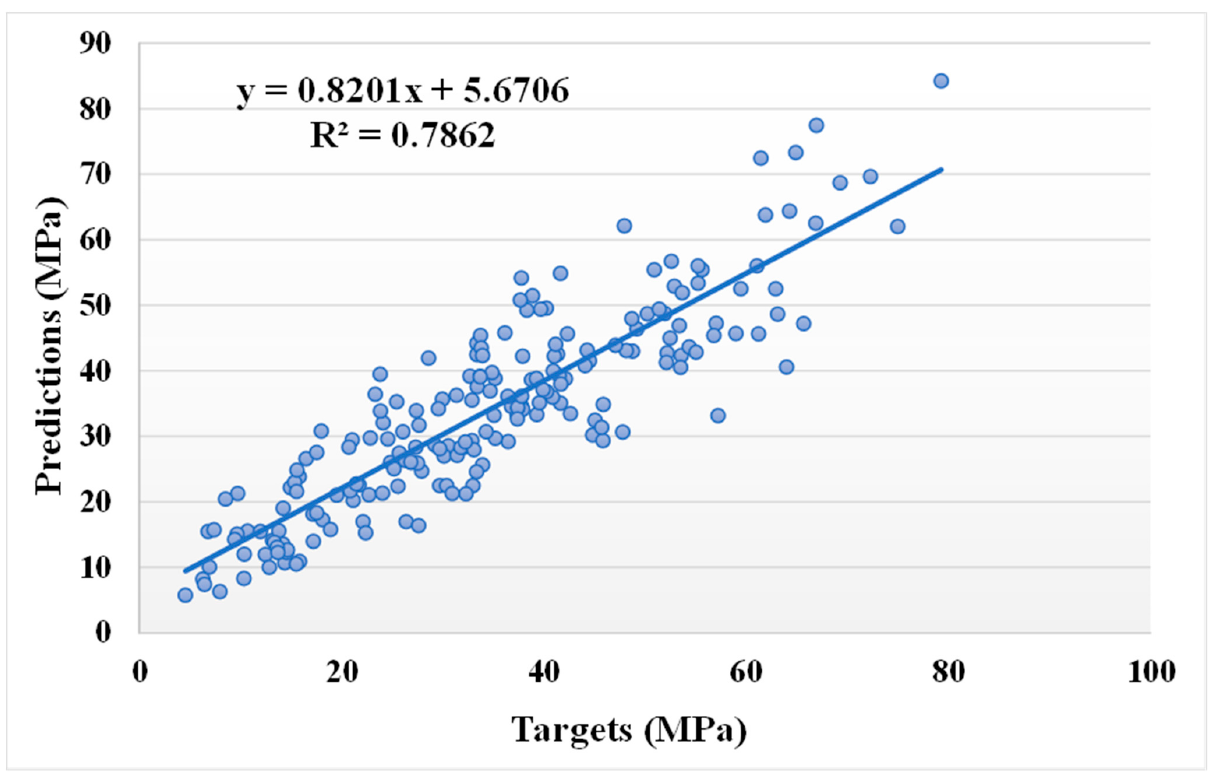
Figure 8. Distribution of actual and predicted values along with the errors for the GEP model.